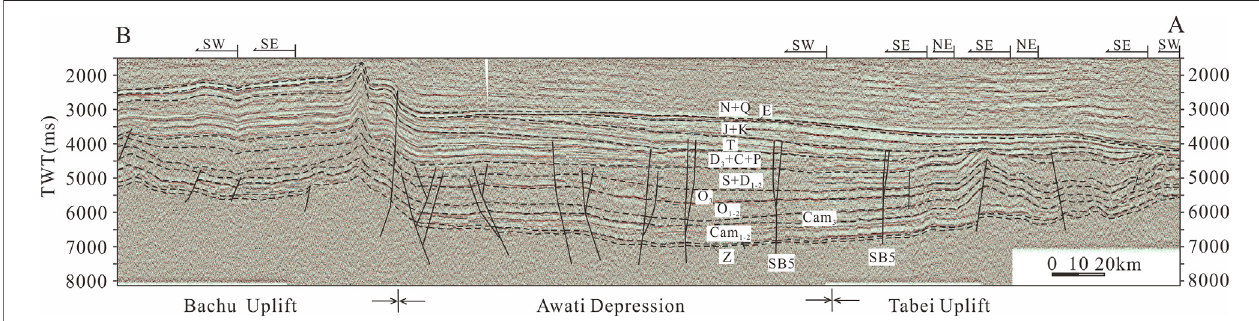
FIGURE 2 | 2D Seismic pro fi le showing some tectonic units of the Tarim Basin. (N + Q)-Neogene and Quaternary, E-Paleogene, (J + K)-Jurassic and Cretaceous, T-Triassic, (D 3 + C + P)-Upper Devonian and Carboniferous and Permian, (S + D 1-2 )-Silurian and Lower and Upper Devonian, O 3 -Upper Ordovician, O 1-2 -Lower and Middle Ordovician,